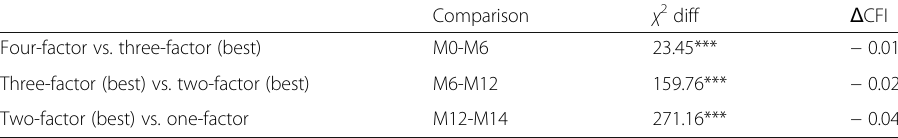
Comparison χ 2 diff Δ CFI